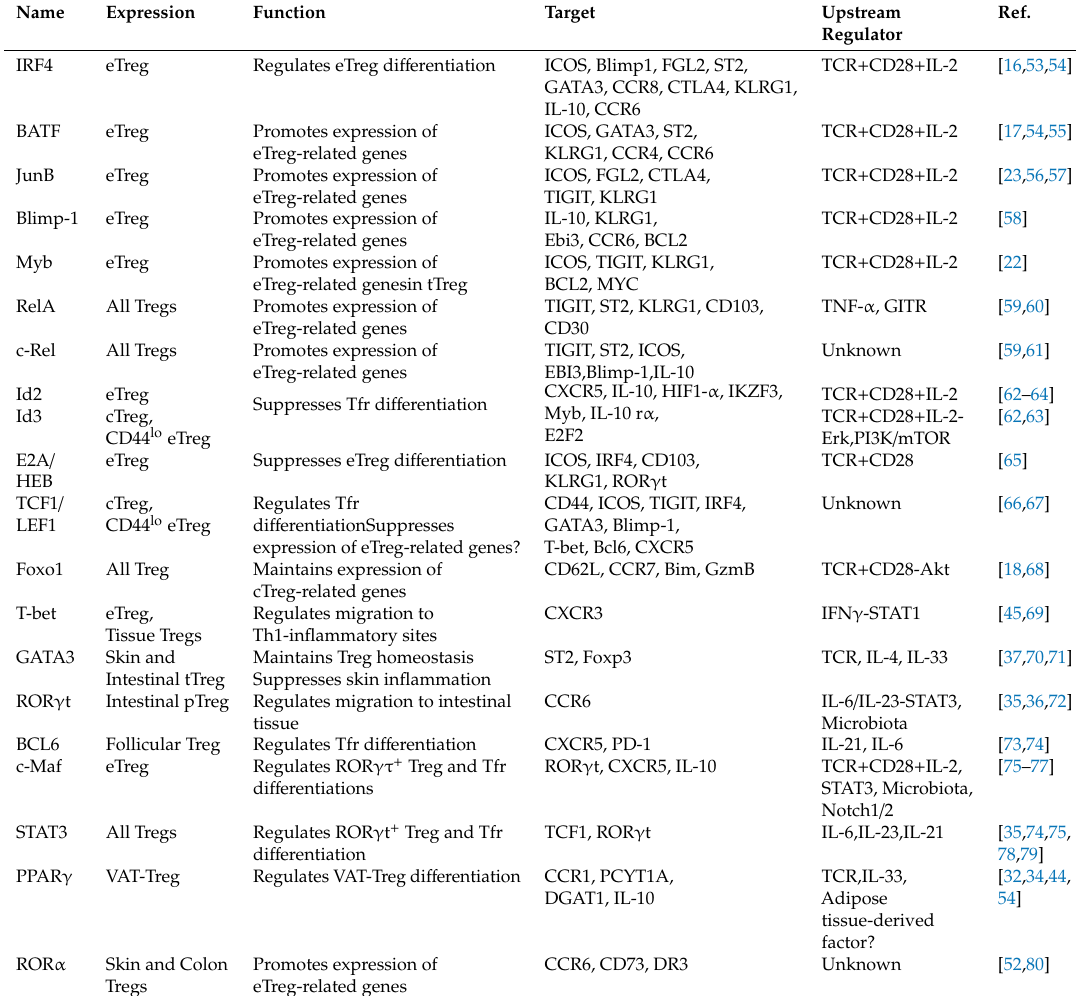
Table 1. A summary of eTreg-related transcription factor expression and